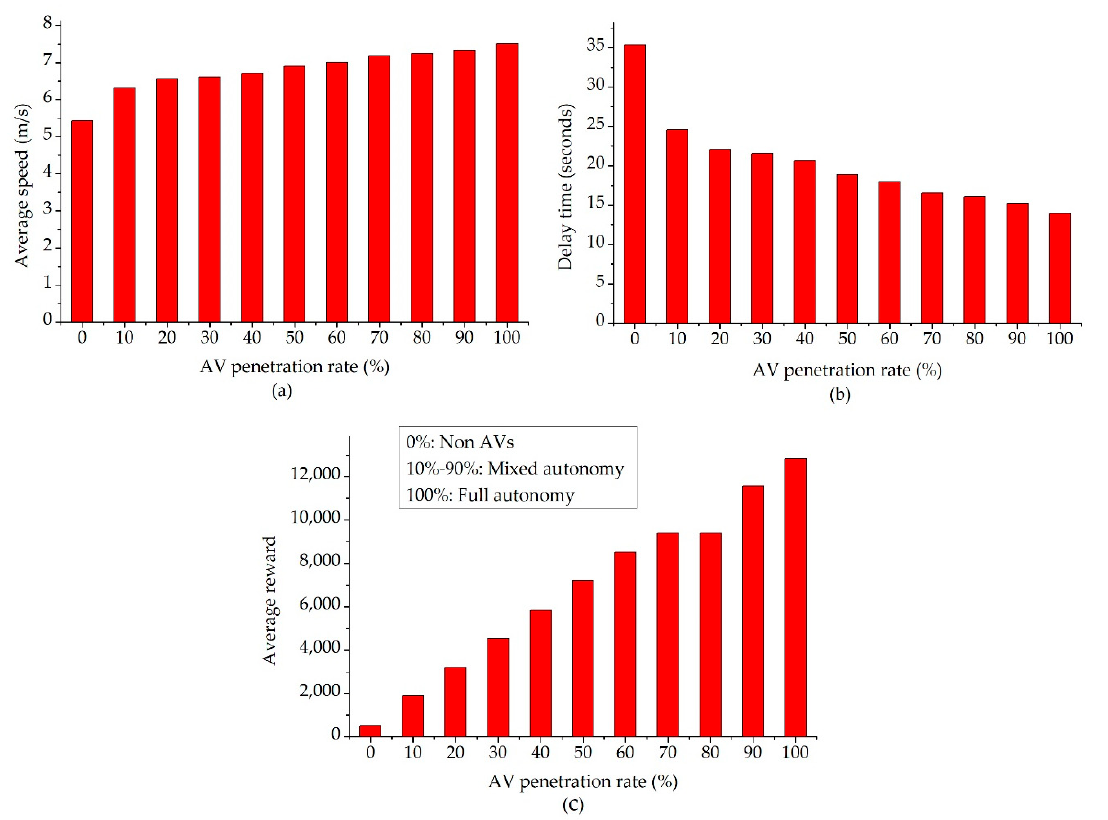
Figure 10. Comparison between the leading autonomous vehicle experiment and the all human-driven vehicle experiment: ( a ) average reward vs. AV penetration rate; ( b ) average speed vs. AV penetration rate; and ( c ) delay time vs. AV penetration rate.